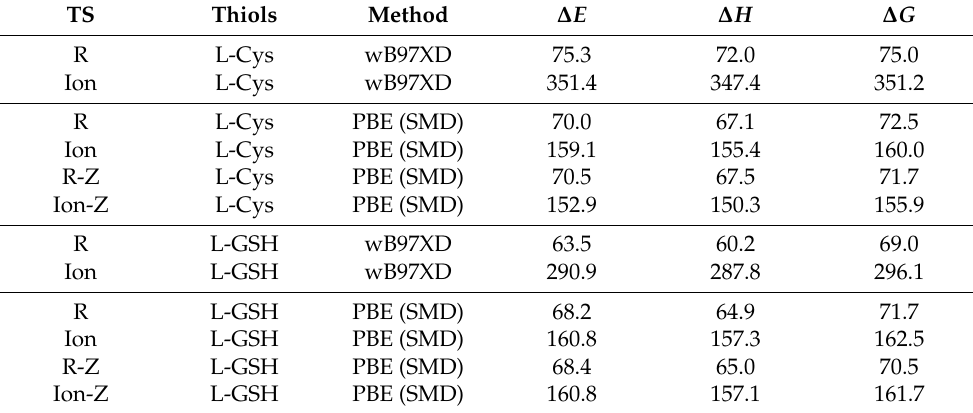
Table 3. Thermodynamics of reactions of ACR with thiols L-Cys and L-GSH in kcal · mol − 1 . R = radical, Ion = ionic, and Z =